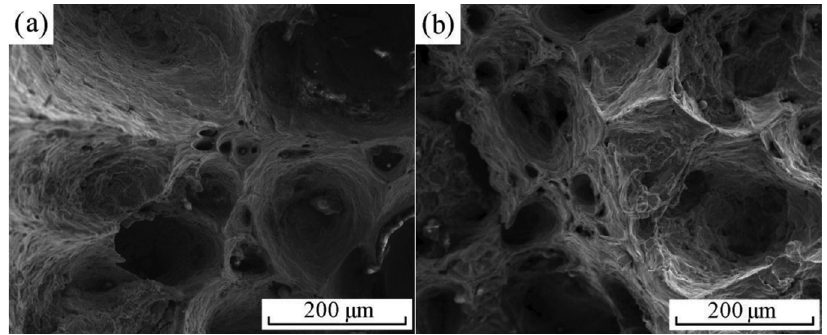
Figure 6: Fractographs of the steel samples A and B at 1,100°C: (a) steel A and (b) steel